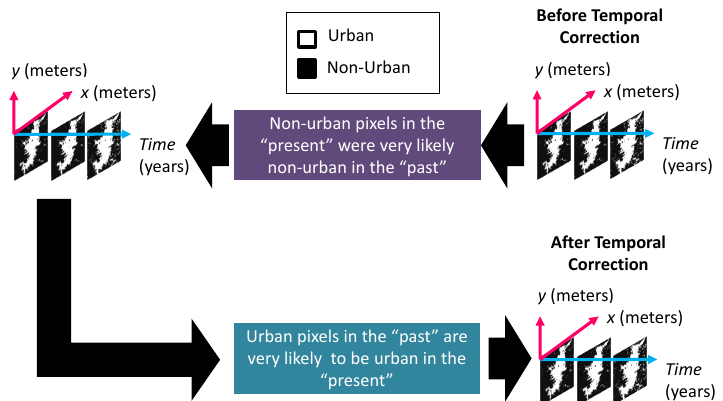
Figure 4. Temporal correction of the binary urban